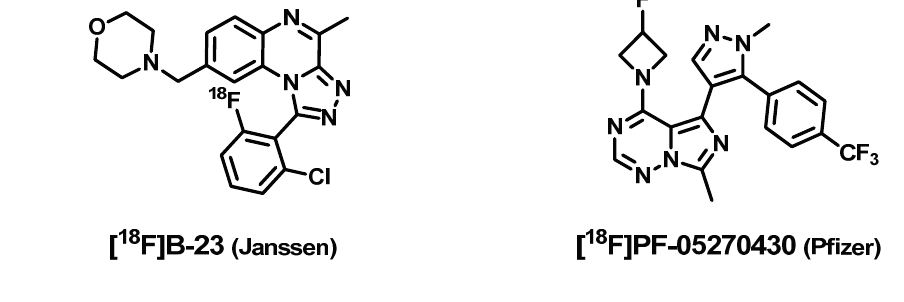
Figure 2. PDE2A radioligands developed by Janssen ([ 18 F]B-23) and Pfizer ([ 18 F]PF-05270430) [3,36,37].